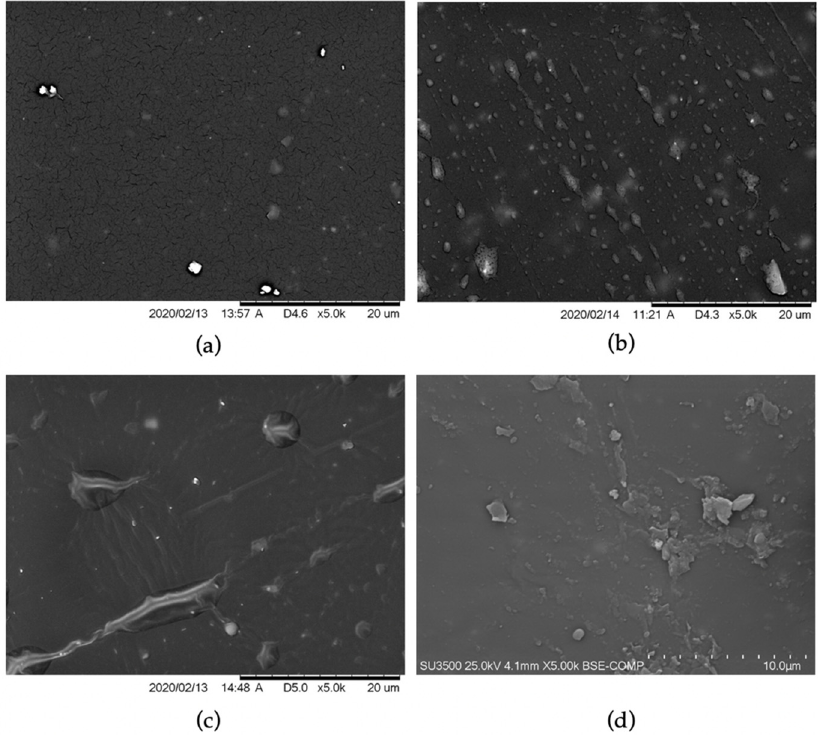
Figure 6. SEM of elastomeric hybrids based on polyurea: ( a ) reference sample; ( b ) 10% Al-FR; ( c ) 10% P-FR; ( d ) 10% P/Cl-FR.